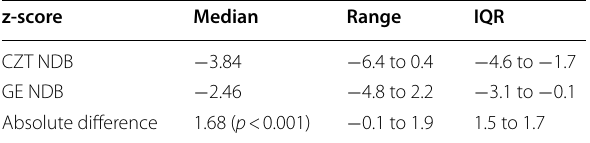
Table 2 Z-scores of the CZT NDB and GE NDB for CZT scans and their absolute difference for the putamen ( n